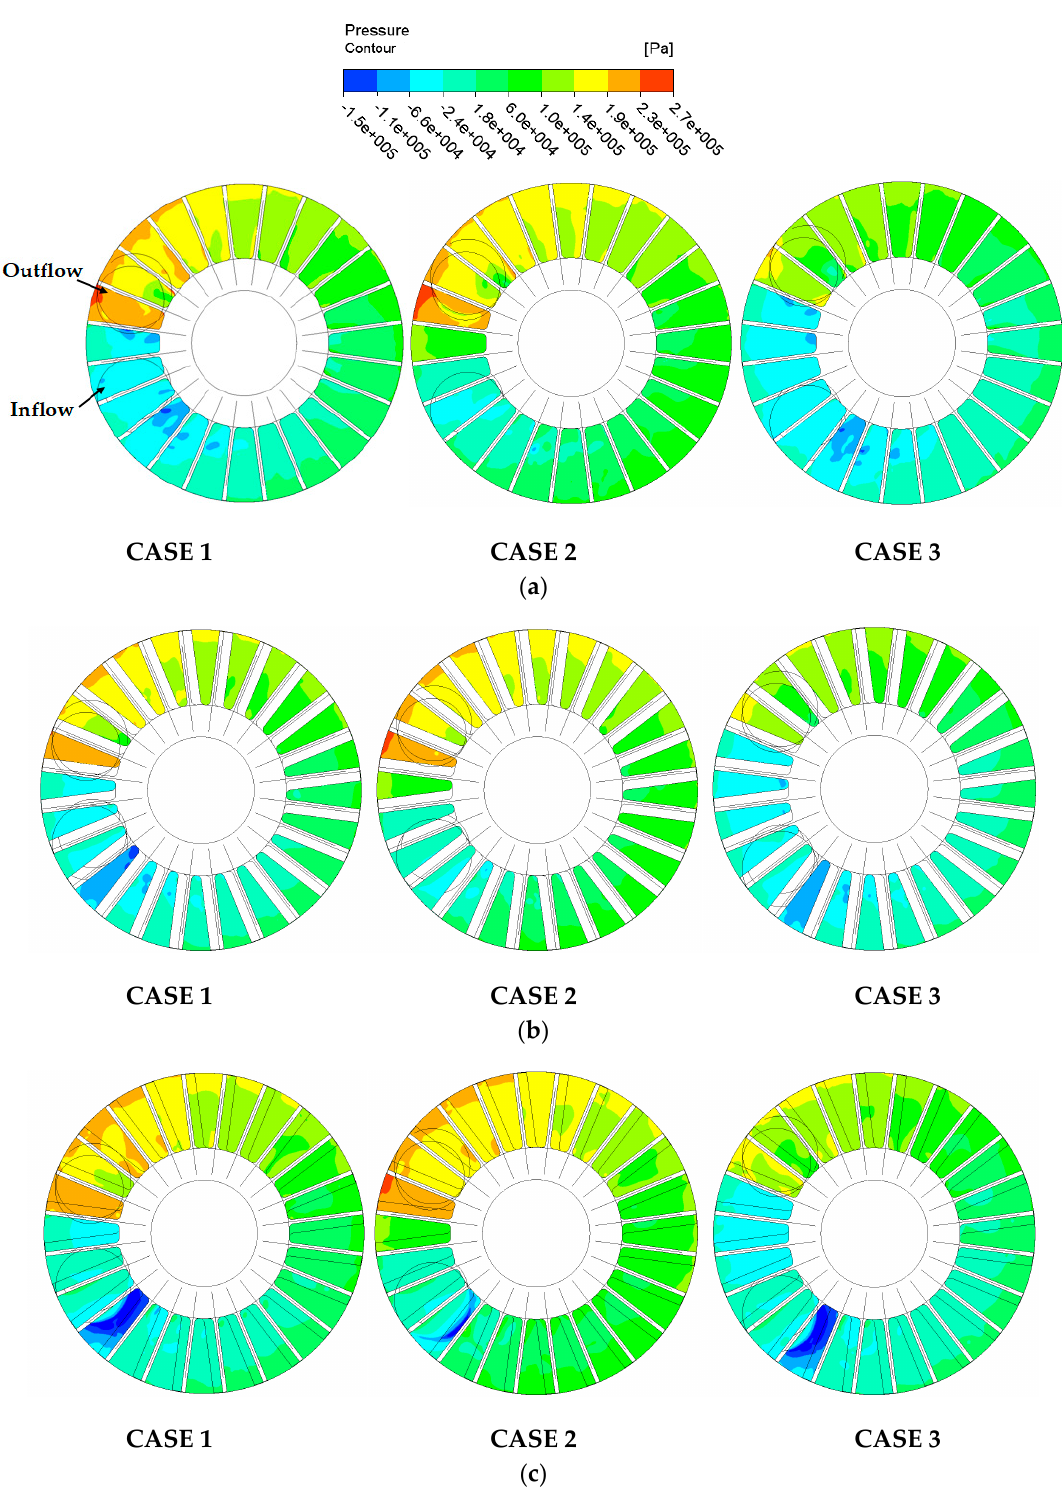
Figure 7. Static pressure distribution in the impeller. ( a ) plane 1 ( b ) plane 2 and ( c ) plane 3.